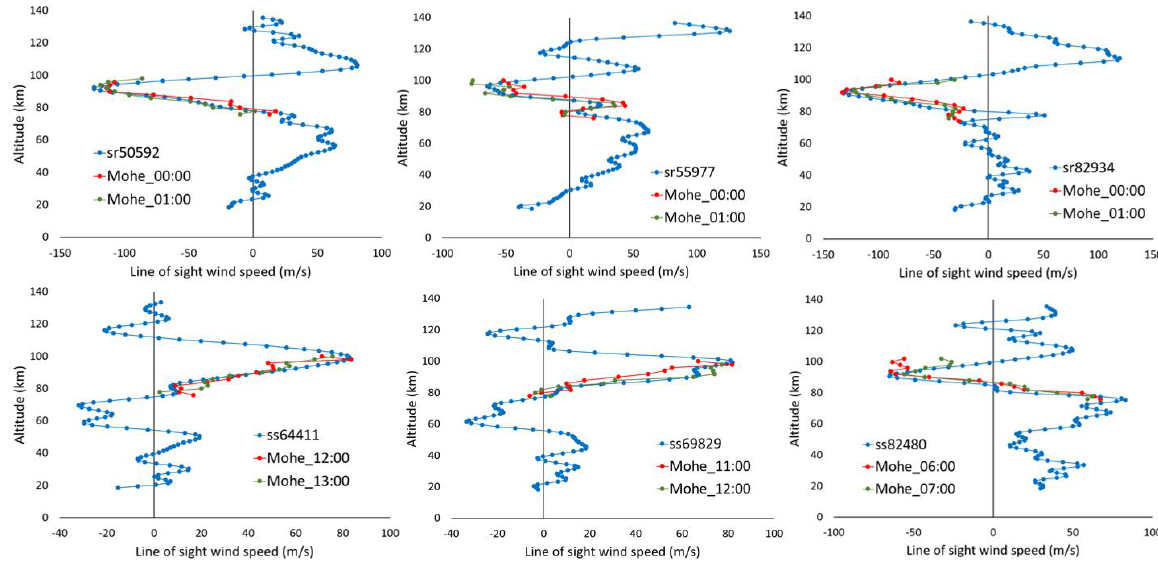
Figure 9. Selected comparisons between coincident ACE-FTS line-of-sight winds (in blue) and vector winds projected onto the ACE-FTS line of sight for hourly results from the Mohe meteor radar station (52.5° N, 122.3° E) prior to (in red) and after (in green) the ACE-FTS measurement. Three sunrise comparisons are shown in the top row: sr50592 (measured 4 January 2013 at 00:20), sr55977 (measured 4 January 2014 at 00:05), and sr82934 (measured 4 January 2019 at 00:30). The bottom row shows comparisons with ACE-FTS sunsets: ss64411 (measured 29 July 2015 at 12:02), ss69829 (measured 9 January 2016 at 07:45), and ss82480 (measured 4 December 2018 at 06:45).